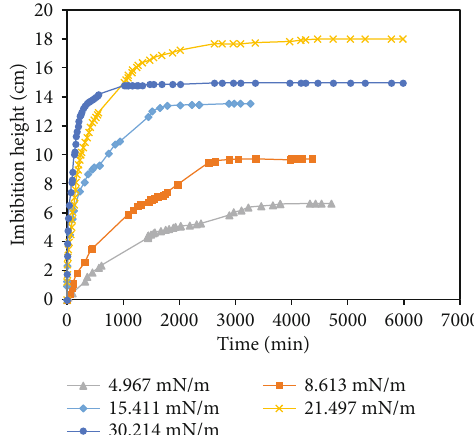
Figure 3: Change in imbibition height with time under di ff erent interfacial tensions with a salinity of 2500